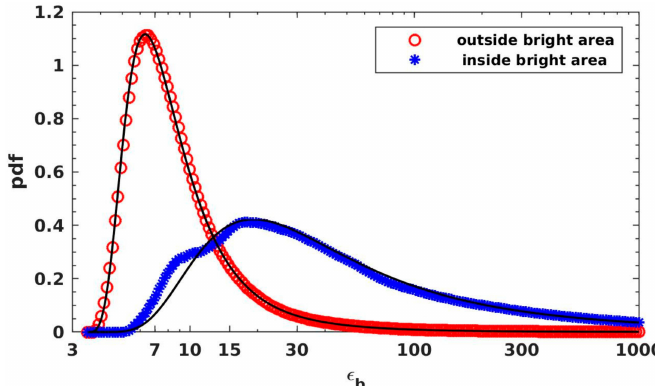
Figure 6. Posterior pdfs of basal permittivity p p ( ε b ∗ ) . In red are indicated the results of the inversion performed outside the bright area, in blue those inside the bright area. The black lines indicate the results obtained by using the curve fitting of Figure